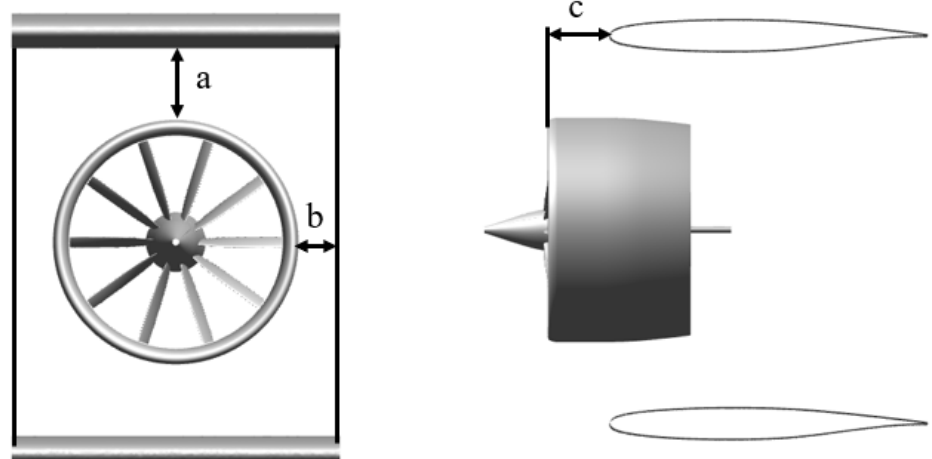
Figure 14. Results comparison between the simulation and experiment.